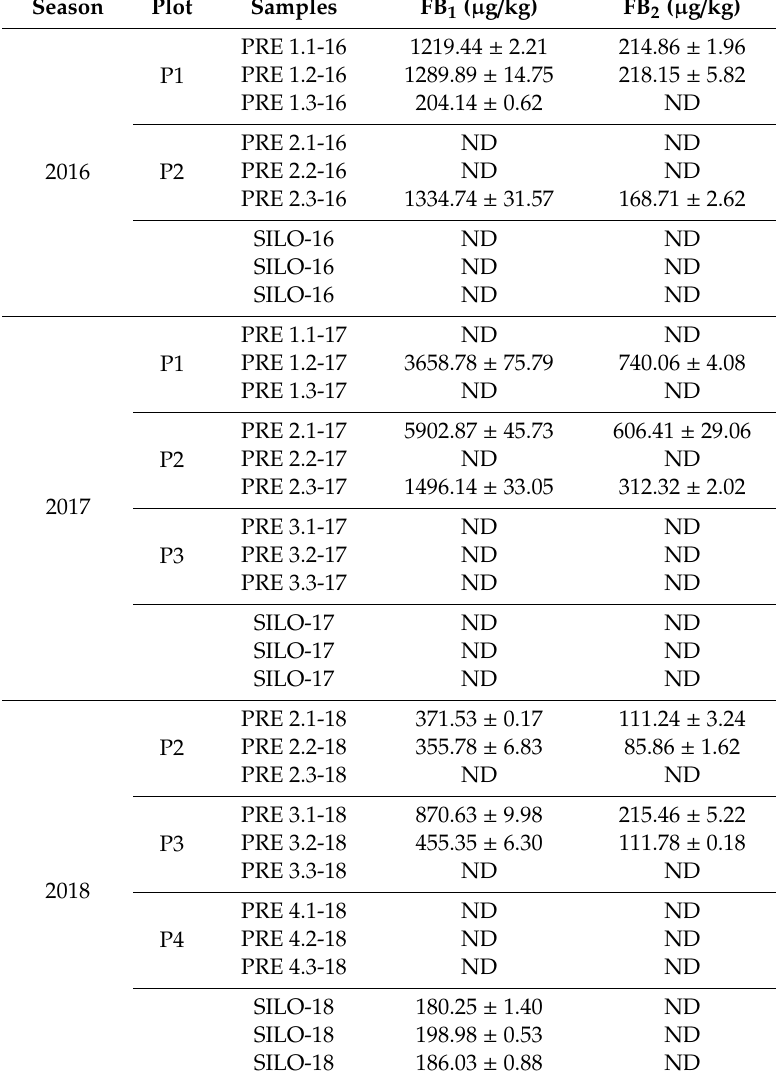
Table 4. Fumonisin concentrations (FB 1 and FB 2 ) in the pre-harvest (PRE) and stored maize samples, across three seasons. Each value corresponds to the mean of two replicates ± standard error. The detection limits were 180 and 60 µ g / kg in the cases of FB 1 and FB 2 ,